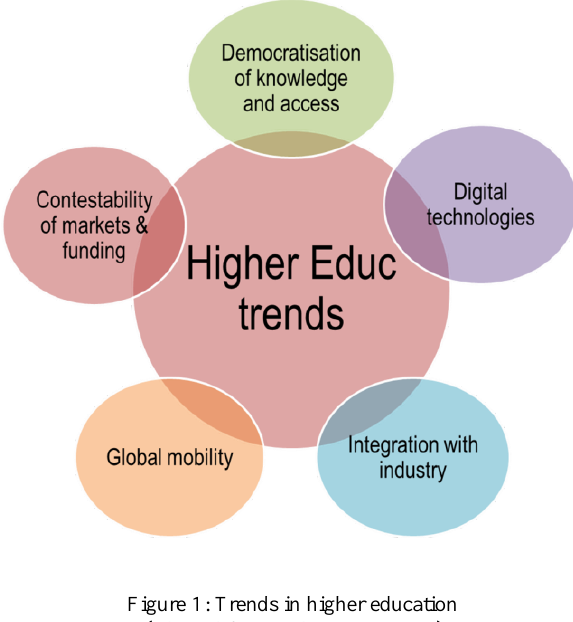
Figure 1: Trends in higher education (adapted from Bokor, 2012, p. 6)